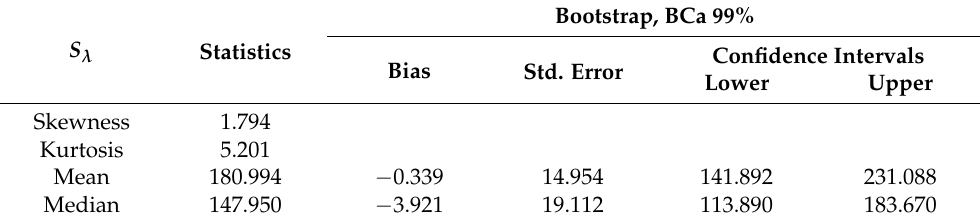
Table 5. Inferential statistics results of derived S λ for M80 decadal dataset at α = 0.01.